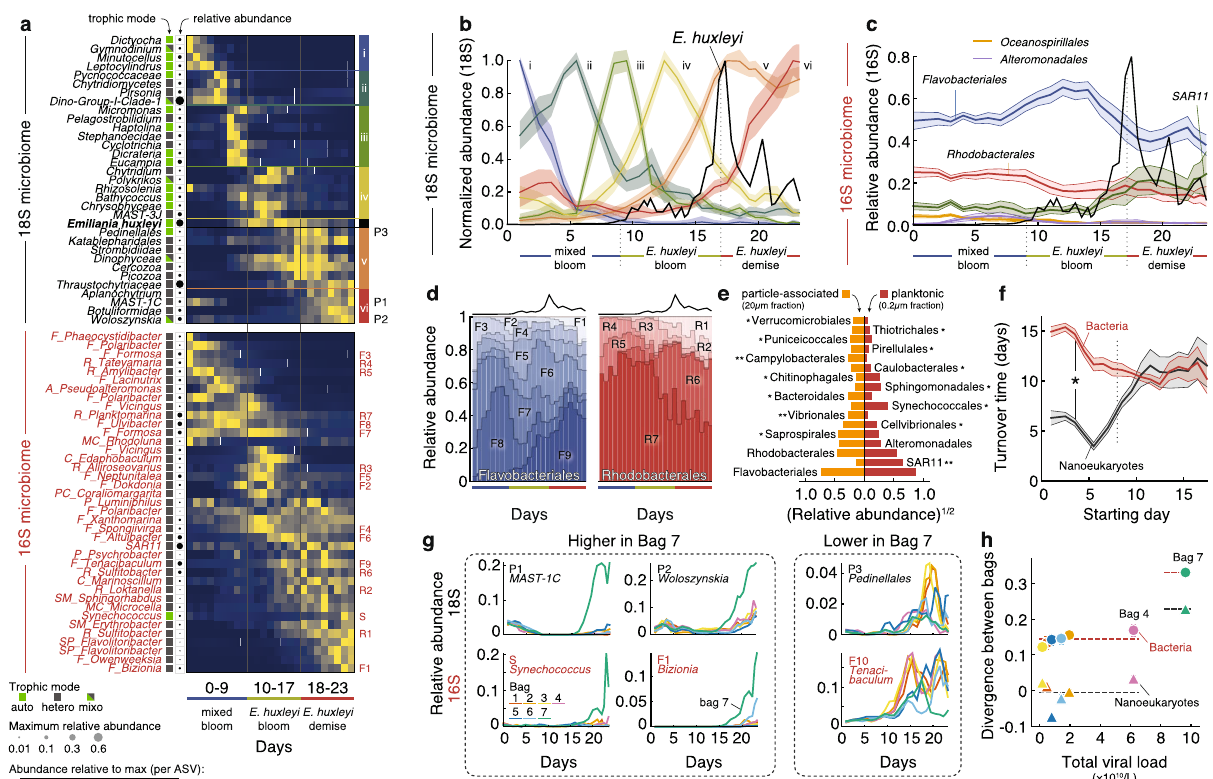
Fig.2|Microbialsuccessionduringthegrowthanddemiseofalgalbloomswith different viral loads. a Nanoeukaryotic (black) and bacterial (red) microbial suc- cessionthroughouttheexperimentduration,averagedacrossenclosures.Eachrow is a taxon with bacteria (ASVs) in red and eukaryotes (named genera) in black. The trophic modes of each ASV are detailed in the box color with autotrophs in green, heterotrophs in gray, and mixotrophs in green/gray. Days are shown in columns. 18S species are grouped by clusters of different colors and taxa of special interest ( d , g ) are indicated on the right of the heatmap. 16S abbreviations denote taxonomy at the order level: F: Flavobacteriales, R: Rhodobacterales, A: Alteromonadales, C: Cytophagales, CV: Cellvibrionales, MC: Micrococcales, P: Pseudomonadales, PC: Puniceicoccales,SM: Sphingomonadales, SP: Saprospirales. b Succession of 18S-based ASVs in the 2 – 20 μ m fraction, clustered by similarity of their relative abundance dynamics averaged across bags. The shaded area repre- sents the standard deviation within each cluster, centered around the mean nor- malized abundanceofspecies inthatcluster. The absolute abundanceof E.huxleyi enumeratedwith fl owcytometryisoverlaidasaguide(blackline,nottoscale).Each cluster is normalized to its own maximum abundance and their species composi- tion is detailed in ( a , c ). Relative abundance of major bacterial orders throughout the bloom, averaged for all enclosures using 16S amplicon sequencing of the